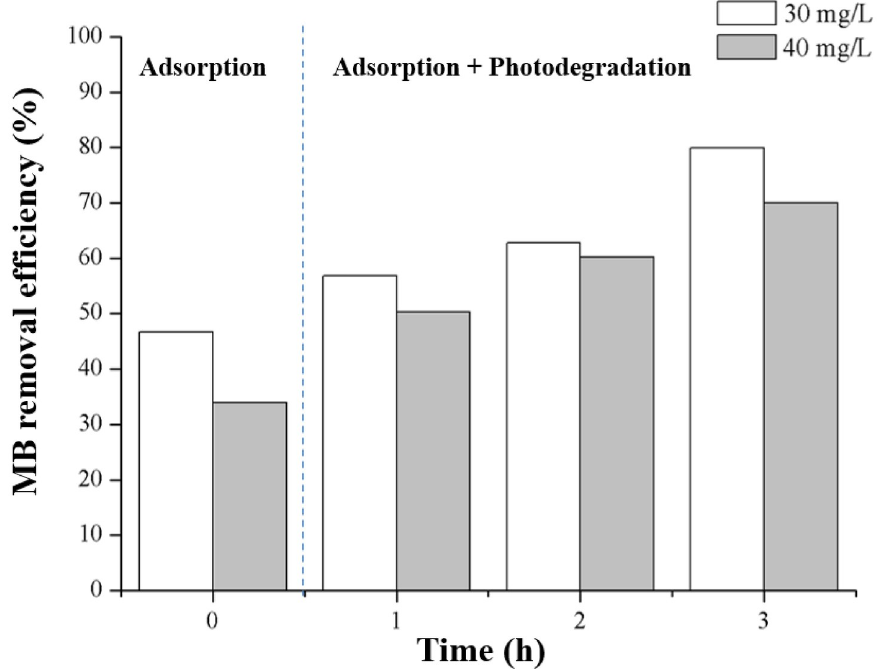
Fig 13. MB removal efficiency (at 30 and 40 mg/L) of the geopolymer composite pellet containing 30 wt% TiO 2 / zeolite.